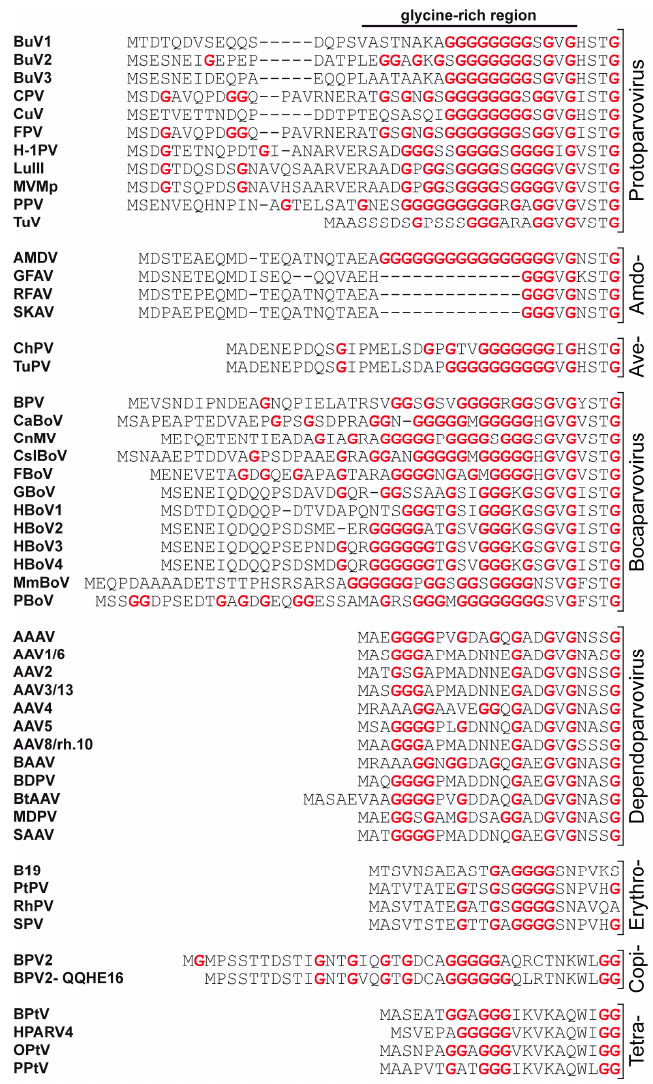
Figure 4. The N ‐ termini of the major VPs of the Parvovirinae . For each genus a selection of available VP sequences are shown for the N ‐ terminal 20–50 amino acids. All glycine residues are shown in red.